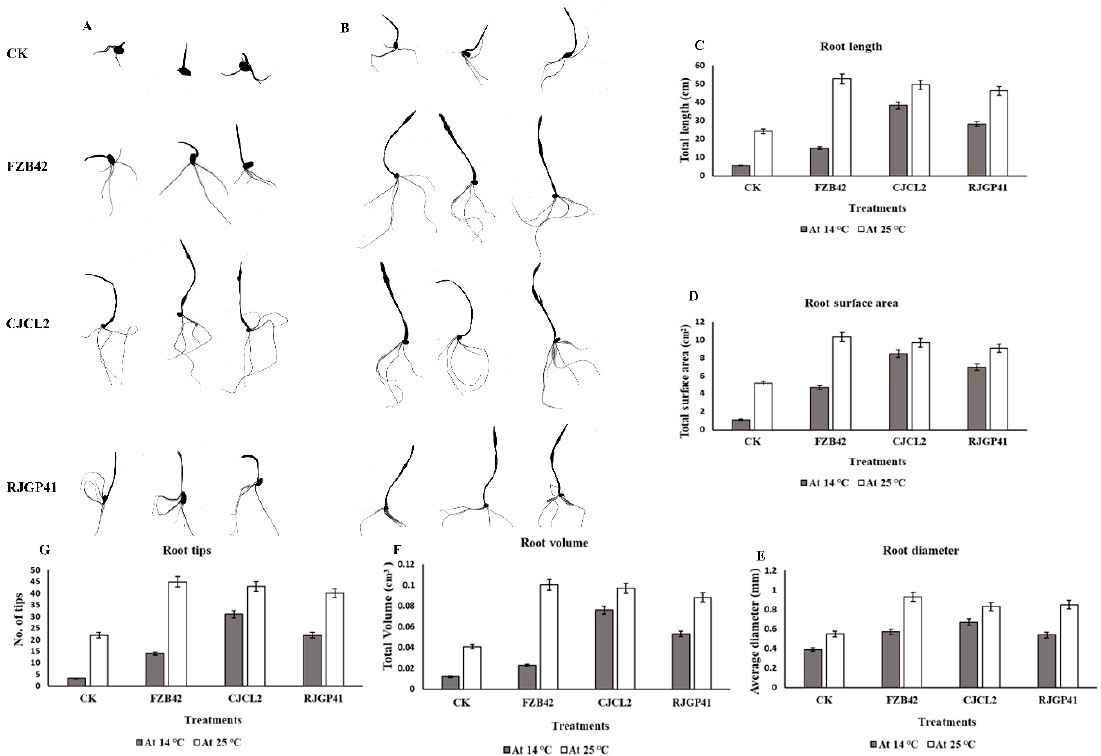
Figure 8. The rhizoscanning image of roots of seedling grown at 14 °C ( A ). The rhizoscanning image of roots of seedling grown at 25 °C ( B ). Root morphology parameters such as total root length (cm) of wheat seedling inoculated with selected Bacillus strains and grown at 14 and 25 °C ( C ). The total surface area (cm 2 ) of roots in wheat seedlings ( D ), the diameter of the roots (mm) ( E ), the total root volume (cm 3 ) ( F ). Number of root tips for each treatment ( G ) is comparatively represented by graphs. The error bars on the graphs indicate the standard error of the means. The significant difference among the treatments was observed by using Tukey’s HSD test at p ≤ 0.05. The experiment was repeated three times with similar results.